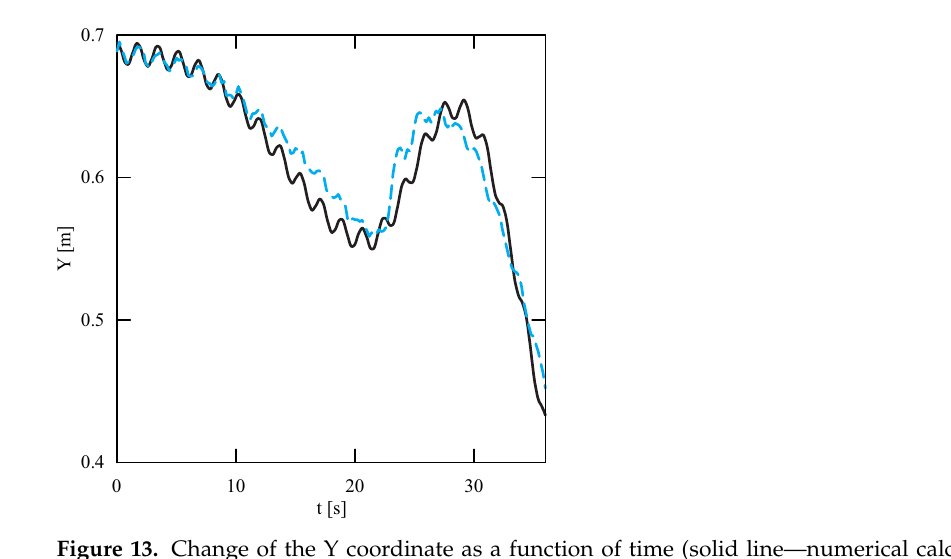
Figure 13. Change of the Y coordinate as a function of time (solid line—numerical calculations, dashed line—experiment results).